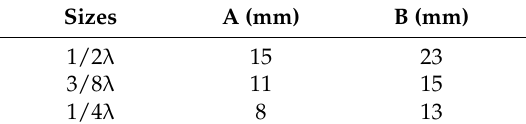
Figure 6. Temperature distributions of the microwave snare at z = − 0.3 mm. Table 4. Relationship between the total length and size of the